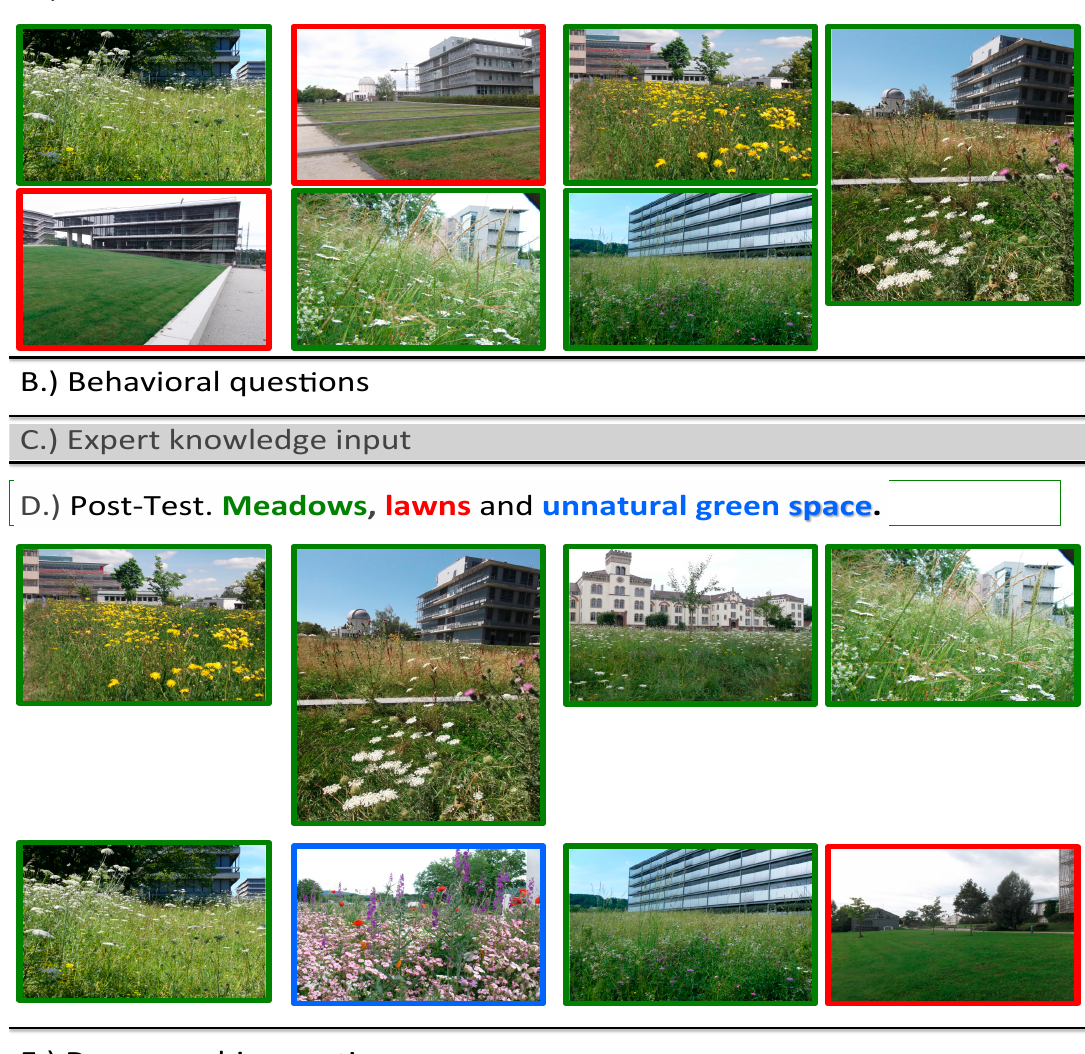
Figure 1. Structure of our questionnaire. ( A ) Pre-testing with meadows (green) and lawns (red); ( B ) Questions on personal behaviour; ( C ) Expert knowledge input; ( D ) Post-test with meadows (green), lawn (red) and unnatural/artificial green space (blue); ( E ) demographic questions. For further explanations see text.